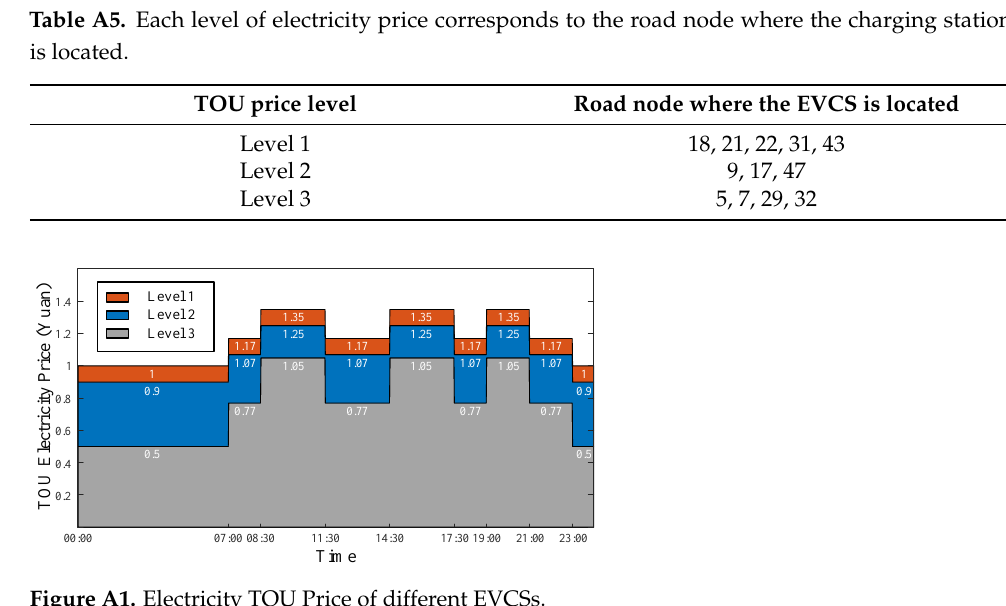
Figure A1. Electricity TOU Price of different EVCSs.